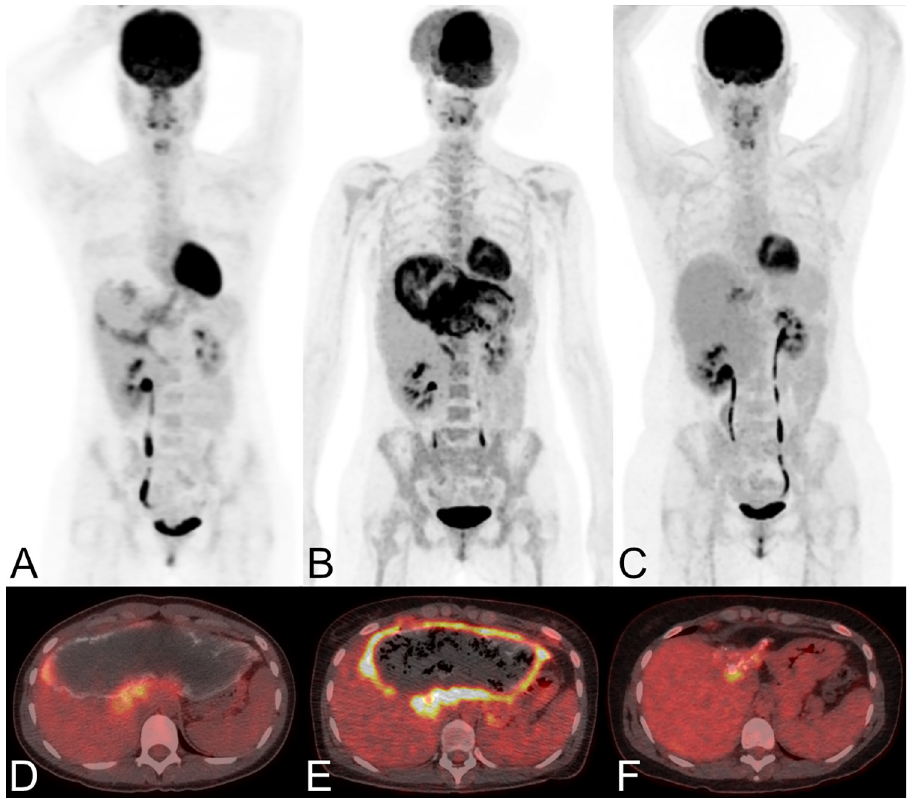
Fig 1. Three PET/CT scans performed in a female patient with a large hepatic manifestation of alveolar echinococcosis. The patient (patient 04 in Table 2 ) was 24 years old in 2005 (maximum intensity reconstructions of PET (A) and fused PET/CT images (D)), 32 years old in 2012 (B and E), and 40 years old in 2020 (C and F). She was treated with albendazol since 1997 and therapy was ongoing at the last clinical follow-up in 2021. In 2005, PET/CT showed moderate metabolic activity (A and D), EgHF AU were 58. In 2012, the patient presented with fever and was diagnosed with cholangitis and subsequently treated with antibiotics—PET/CT showed intense metabolic activity in the periphery of the echinococcosis manifestation (B and E), EgHF AU were lower than in 2005 (i.e., 46). In 2020 (C and F), PET/CT again showed moderate metabolic activity to a lesser extent, EgHF AU were 13. The large discrepancy in trends in this case, may indicate, that metabolic activity and EgHF antibody levels may have to be evaluated independently, when treating patients with alveolar echinococcosis.